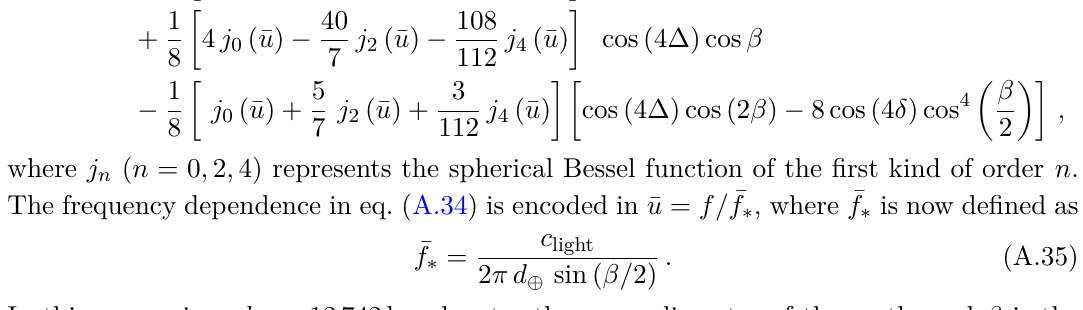
Table 3 . Geometrical data describing the angular separation and relative orientation of the six detector pairs that can be formed within the HLVK detector network (see refs. [197, 198] for details). or alternatively, the normalized overlap reduction function γ 1 γ ( f ) = − IJ